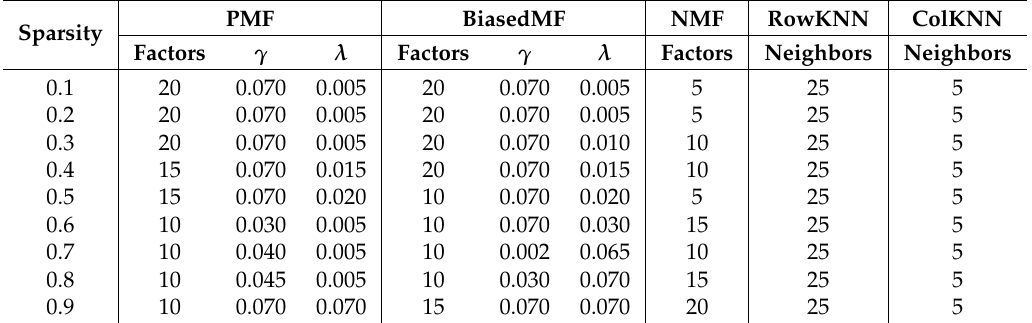
Table 3. Most adequate hyper-parameters reported by a grid search optimization on the synthetic dataset.